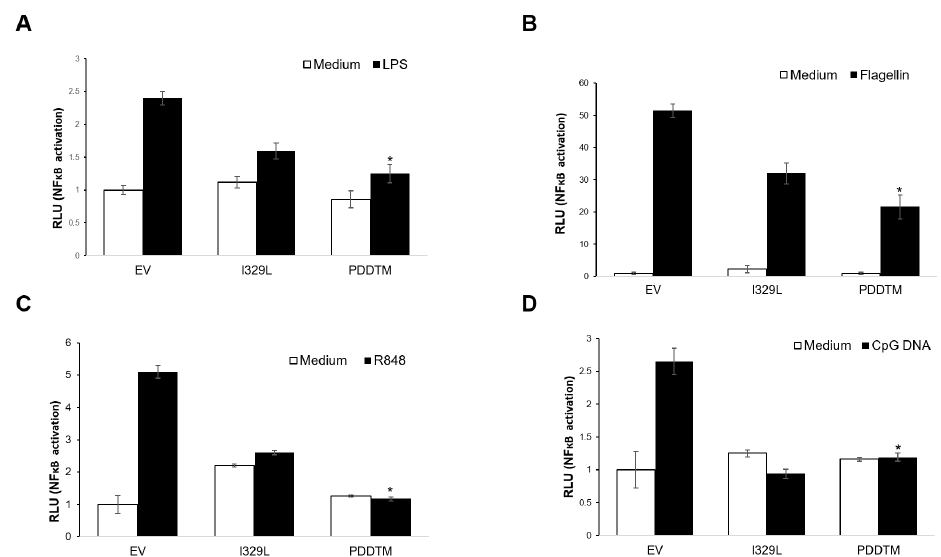
Figure 5. I329L is a general inhibitor of TLR signalling. ( A ) Vero cells were co-transfected with either the empty vector pcDNA3HA (EV), pcDNA3-I329L-HA, or pcDNA3-PDDTM-HA, the NF- κ B luciferase reporter and the β -galactosidase internal control plasmid. Cells were induced with 100 ng/mL LPS (TLR4 ligand) or left untreated (medium). ( B , C ) HEK-293T cells were co-transfected with pcDNA3HA (EV) or pcDNA3-I329L-HA, or pcDNA3-PDDTM-HA, the NF- κ B luciferase reporter, the β -galactosidase internal control plasmid, and TLR5, or TLR8 expression plasmids. Cells were either induced with 100 ng/mL Flagellin (TLR5 ligand) ( B ), 1 μ g/mL R848 (TLR8 ligand) ( C ) or left untreated (medium). ( D ) Vero cells were co-transfected with either pcDNA3-HA (EV), pcDNA3-I329L-HA, or pcDNA3-PDDTM-HA, the NF- κ B luciferase reporter and the β -galactosidase internal control plasmid. Cells were either induced with 10 μ g/mL ODN2006 (TLR9 ligand) or left untreated of relative luciferase units (RLU) ± SD of triplicate culture wells and are representative of three independ-